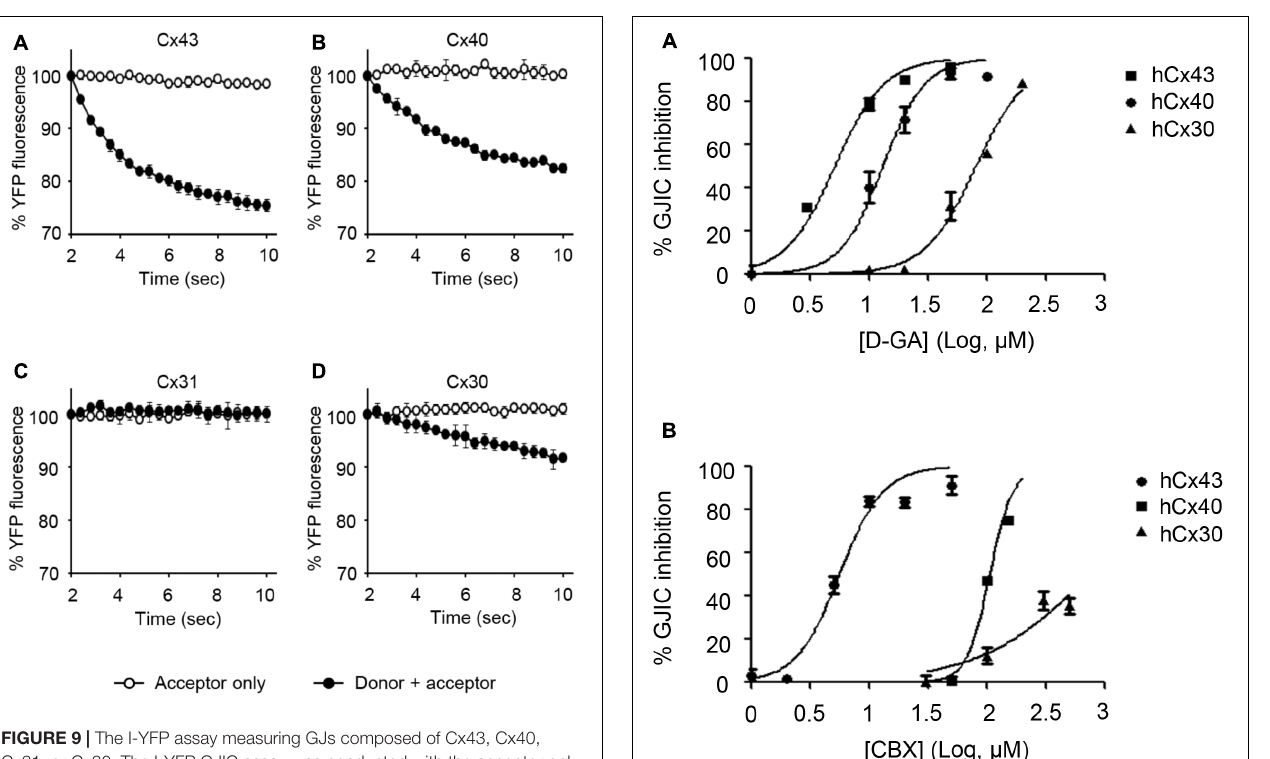
FIGURE 9 | The I-YFP assay measuring GJs composed of Cx43, Cx40, Cx31, or Cx30. The I-YFP GJIC assay was conducted with the acceptor only for 10 s. The percentage of YFP fluorescence was plotted against assay time. The data represent the mean ± SD ( n = 3). with an anti-Cx43 and anti-phospho-S368 Cx43 antibodies. The